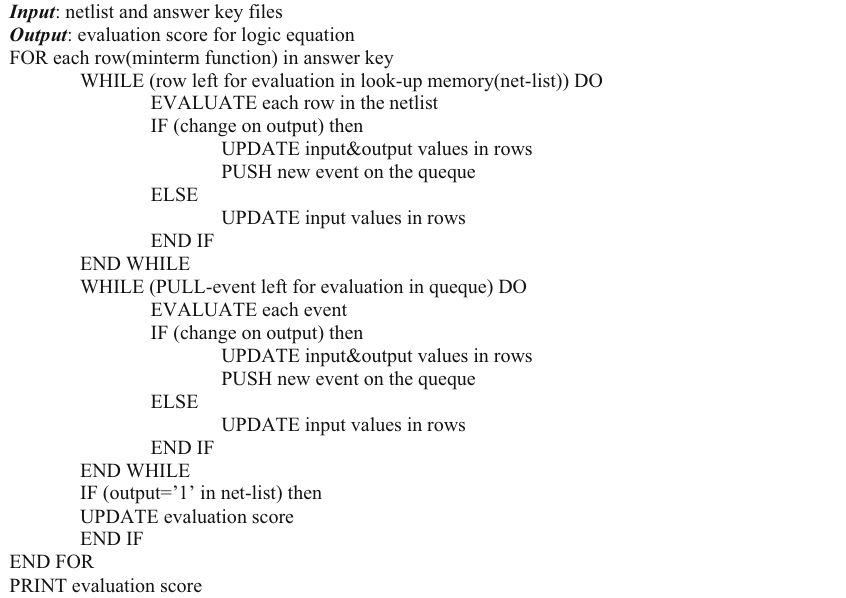
Figure 5: Algorithm to determine the logic behavior of a